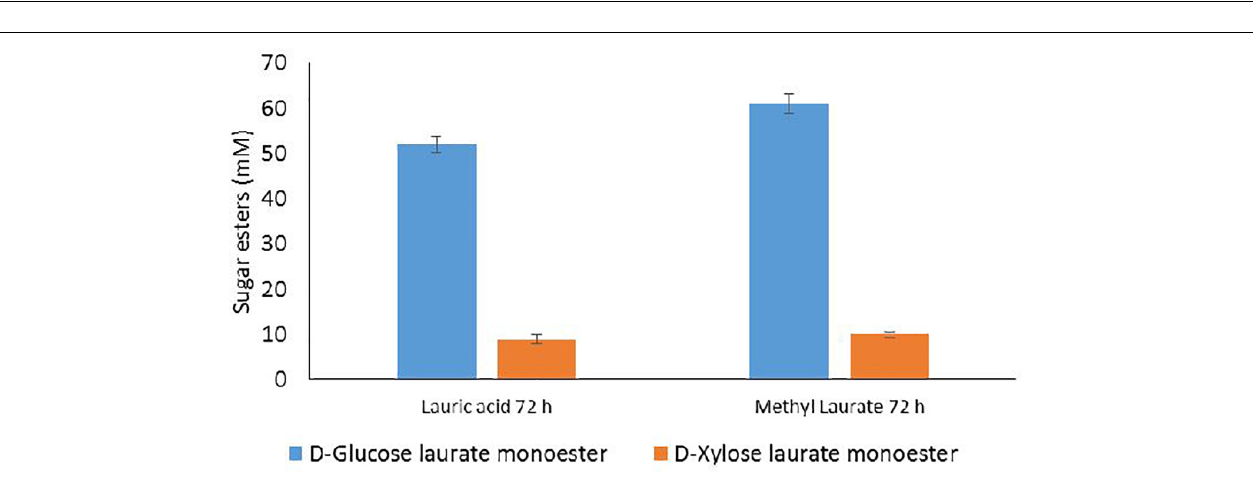
FIGURE 5 | Successive transglycosylation and (trans)esterification reactions to produce pentyl xyloside and sugar esters from a single batch of wheat bran.